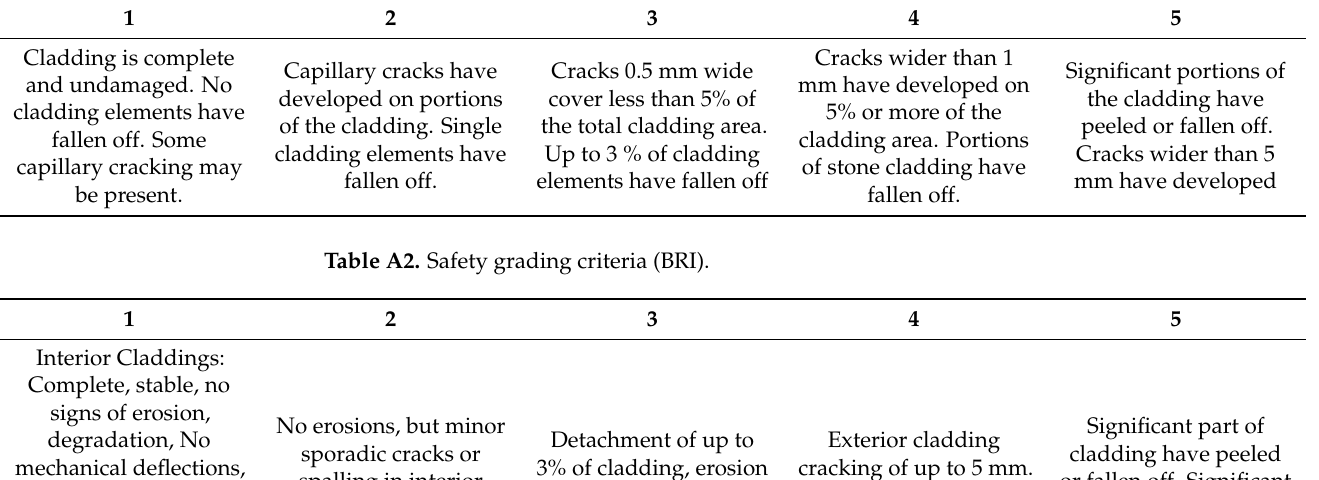
Table A1. Maintenance grading criteria (MI).